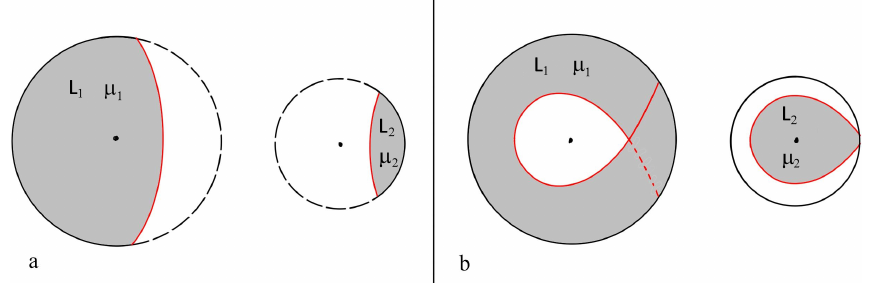
Figure 3. Gravitational solutions for interface CFTs (shaded regions are kept). (a) Regions of AdS soliton solutions dual to the separate CFTs on periodic directions are glued together along an interface. (b) For an interface tension approaching a lower critical value, the outer region is multiply wound relative to the original AdS soliton geometry, leading to an enhanced negative energy for the CFT with more degrees of